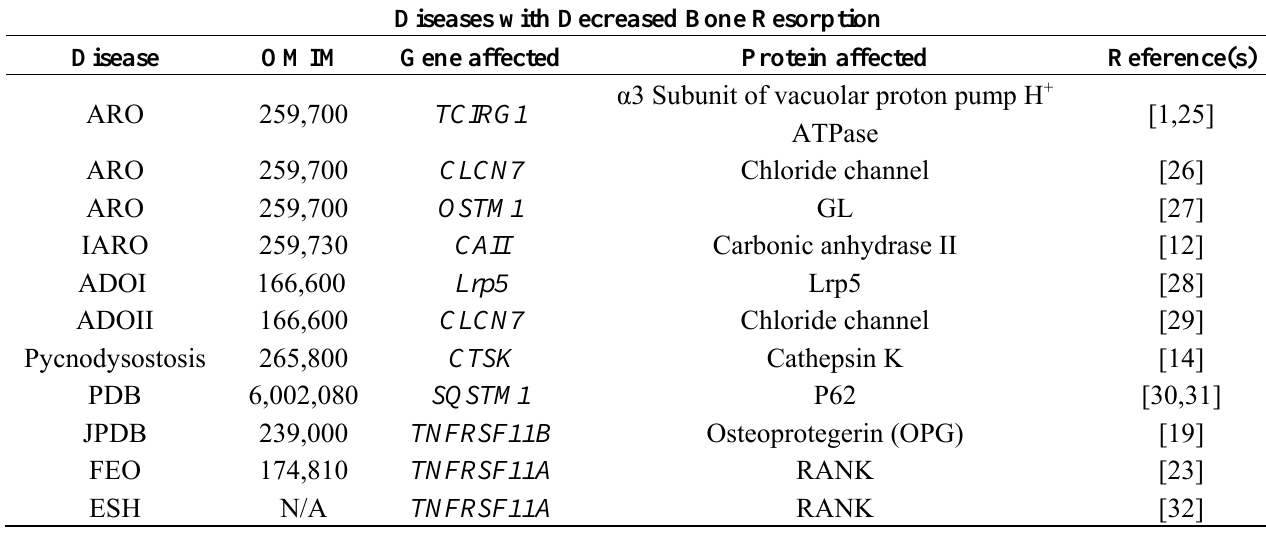
Table 1. Mutations in rare genetic bone disorders with osteoclast defects. Diseases with Decreased Bone